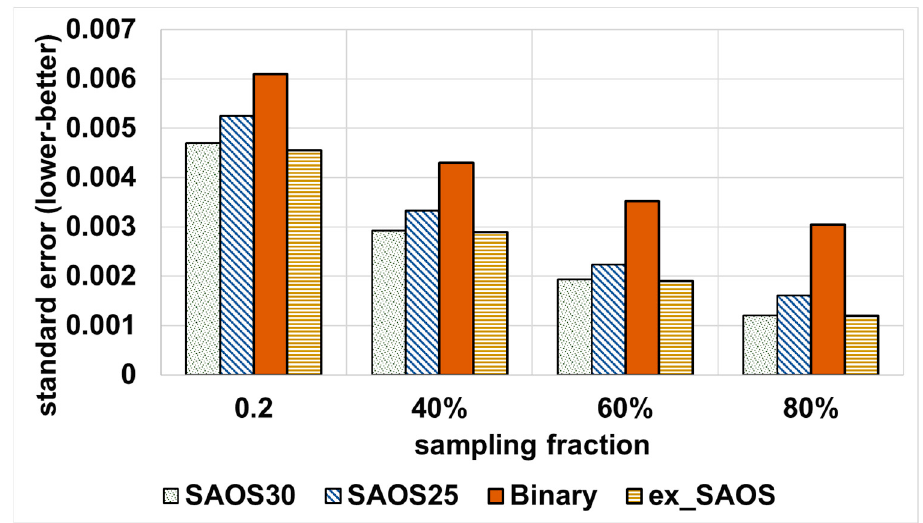
Figure 7. Standard error achieved by all systems, including ApproxSSPS: ‘computing the average “trip distance” in NYC taxicab mobility data’. Similar to Shenzhen data, ex-SAOS and SAOS at geohash precision 30 achieve the lowest standard error. SAOS at geohash 25, instead, achieves a higher standard error, which, however, remains significantly lower than that of the baseline.